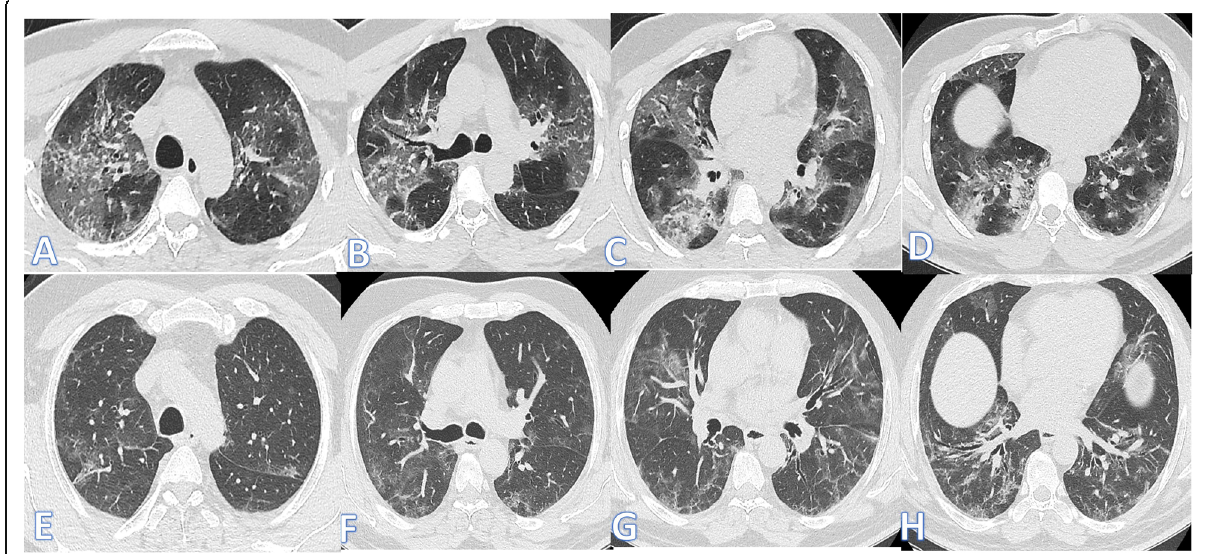
Fig. 8 Thirty-nine-year-old male: he has DM and HTN; peak CT severity score 17; consolidation/crazy-paving score 13. He was admitted to the ICU; laboratory results showed lymphopenia, high CRP, D -dimer, and serum ferritin. Steroid was given; length of stay during hospitalization is 20 days. Peak CT during admission ( a – d ) showed bilateral GGO with mild interstitial thickening and basal consolidation patches. Follow-up CT